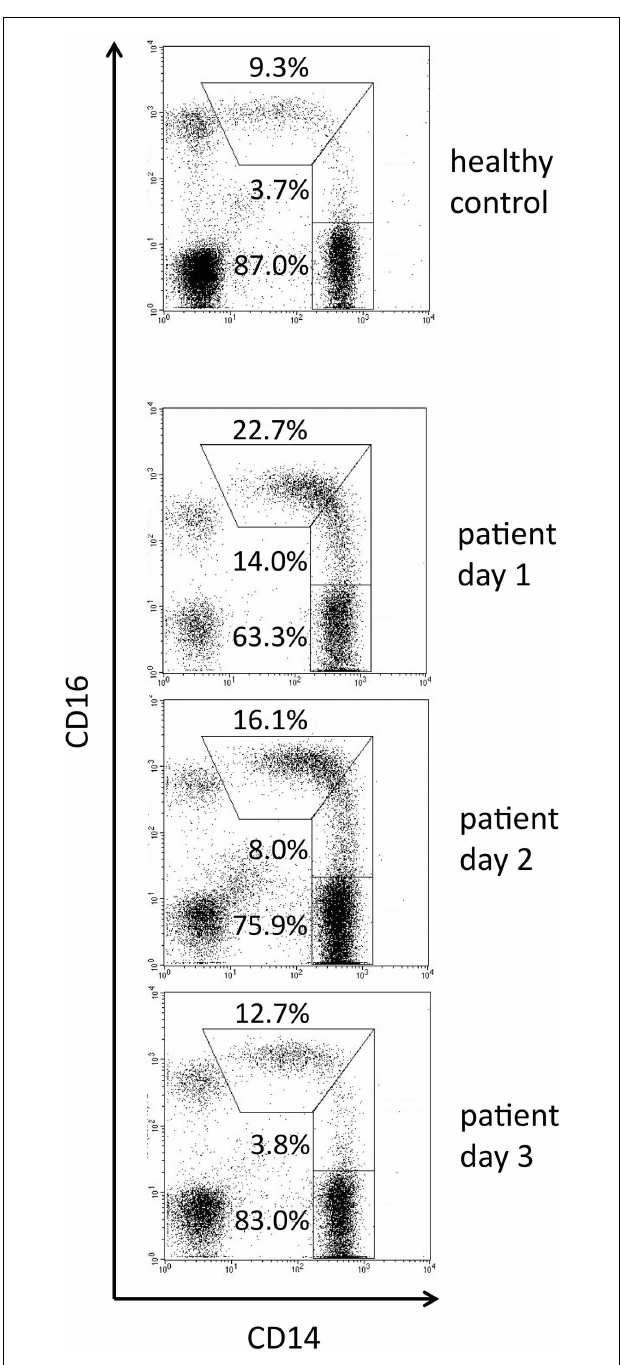
FIGURE 3 |Time course of monocyte subpopulations during natural infection. Blood samples were taken from a control donor and on consecutive days from a patient with skin infection by beta-hemolytic streptococci group A (erysipelas). First symptoms of lower limb inflammation occurred on day 2, day 1 is the day of admission to hospital. The flow cytometry setting was such that a high signal to noise ratio for CD16 allowed for clear display of the intermediate monocytes.Taken from thesis work of Alexia Horelt, Faculty of Medicine, Ludwig-Maximilians University of Munich, 2003. Other parts of the thesis have been published in Horelt et al.